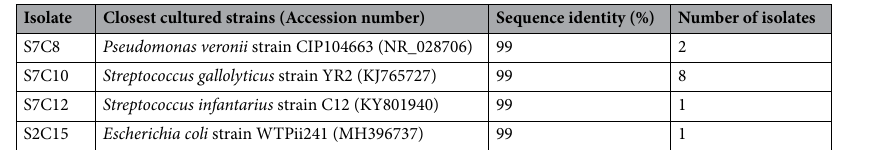
Table 2. 16S rRNA gene sequences of tannin-degrading bacteria isolated from Yaku sika rumen.